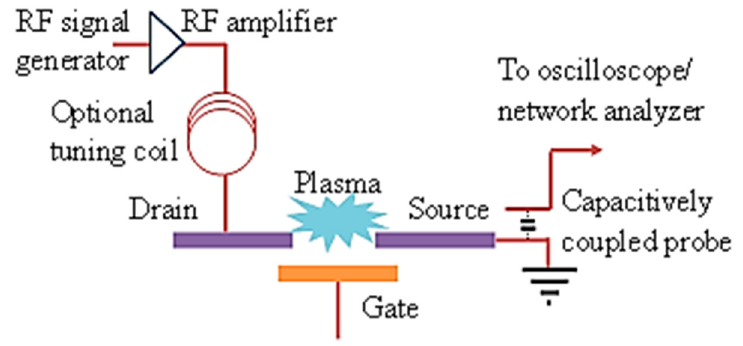
Figure 12. Schematic of the RF measurement experimental setup. The MOPFET device is shown in Figure 10 [25].